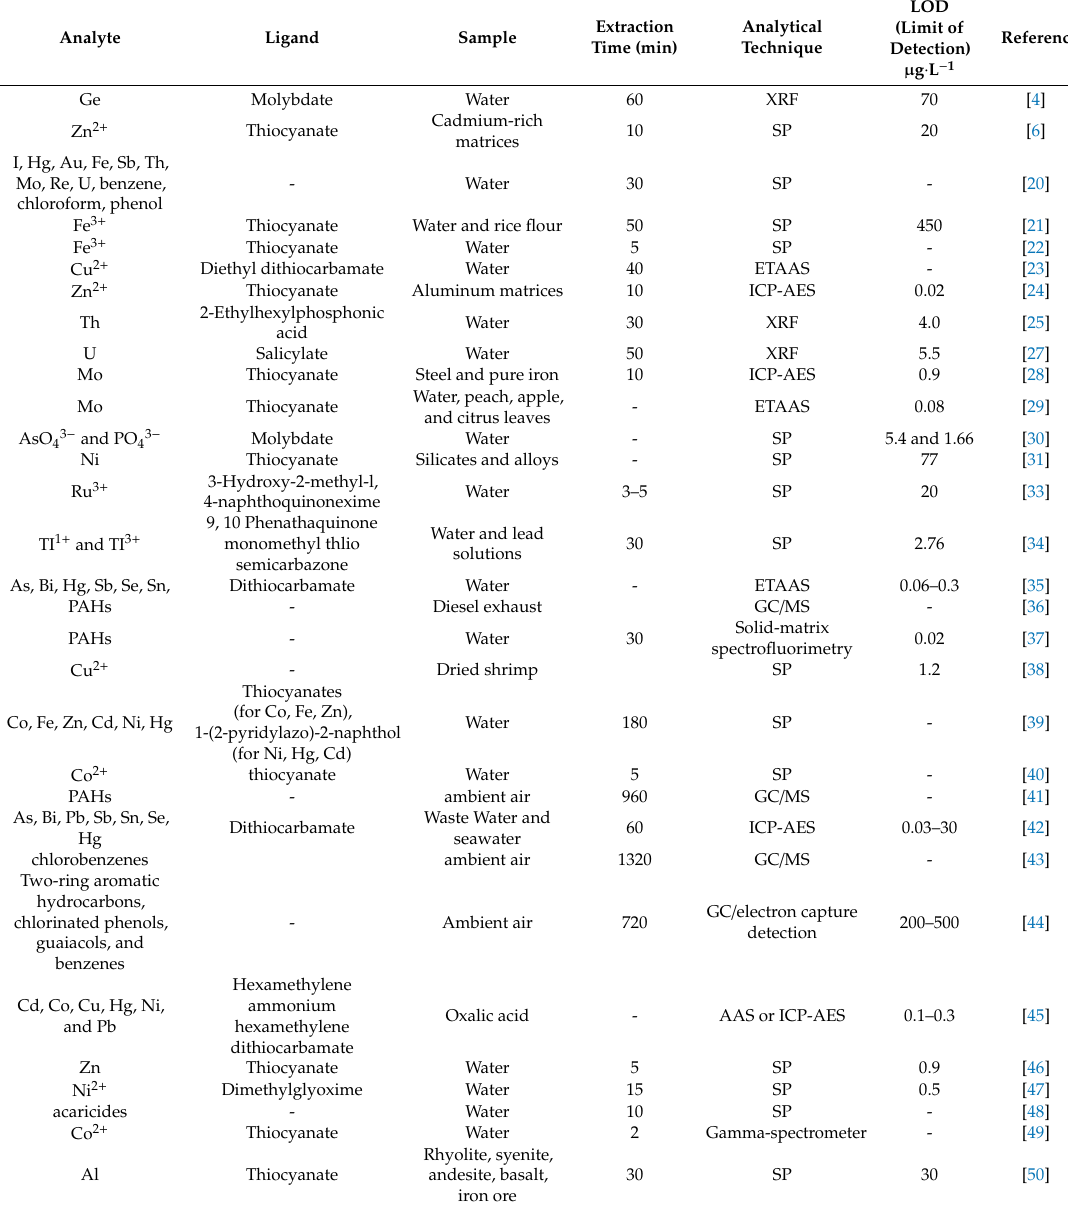
Table 1. Summary of the analytical methods developed, between 1990 and 2005, based on polyurethane foams (PUFs), SP: spectrophotometry; ETAAS: electrothermal atomic absorption spectrometry; XRF: X-ray fluorescence spectrometry; AAS: atomic absorption spectrometry; ICP-AES: inductively coupled plasma atomic emission spectrometry; PAH: polycyclic aromatic